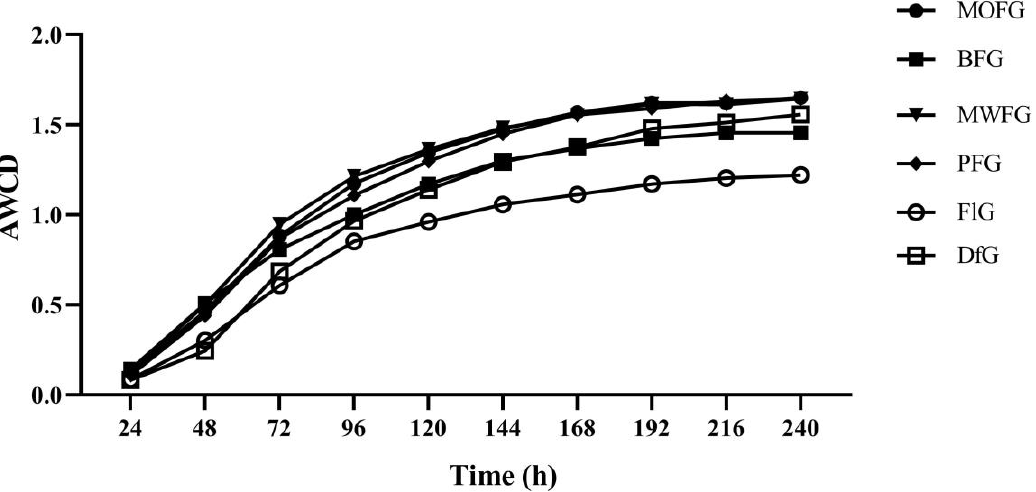
Figure 1. The AWCD value of the soil microorganisms. MOFG, Mongolian oak forest ginseng; BFG, birch forest ginseng; MWFG, miscellaneous wood forest ginseng; PFG, poplar forest ginseng; FlG, farmland ginseng; DfG, deforestation ginseng.